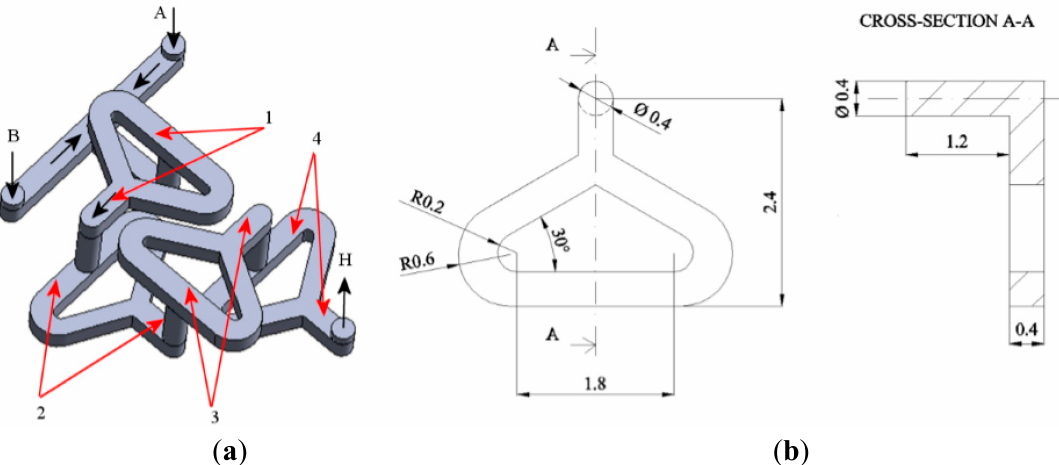
Figure 1. Geometry of the Tear-drop micromixer (dimensions in mm): ( a ) three-dimensional view; ( b ) top view of one element and cross-section.